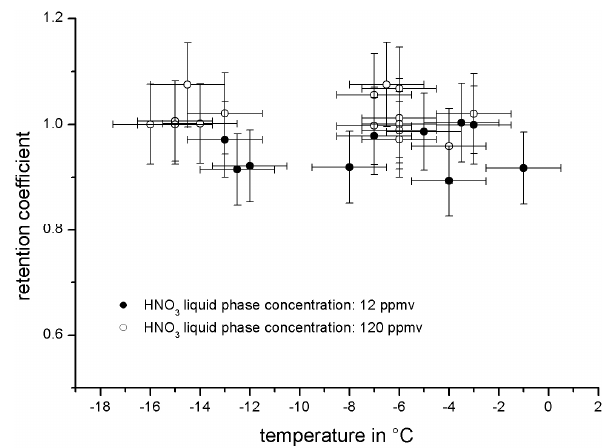
Fig. 1. Retention coefficient of HNO 3 as a function of ambient air temperature, determined with captively floating ice particles rimed with solution droplets of two concentrations (black circles: 12ppmv, open circles: 120ppmv).